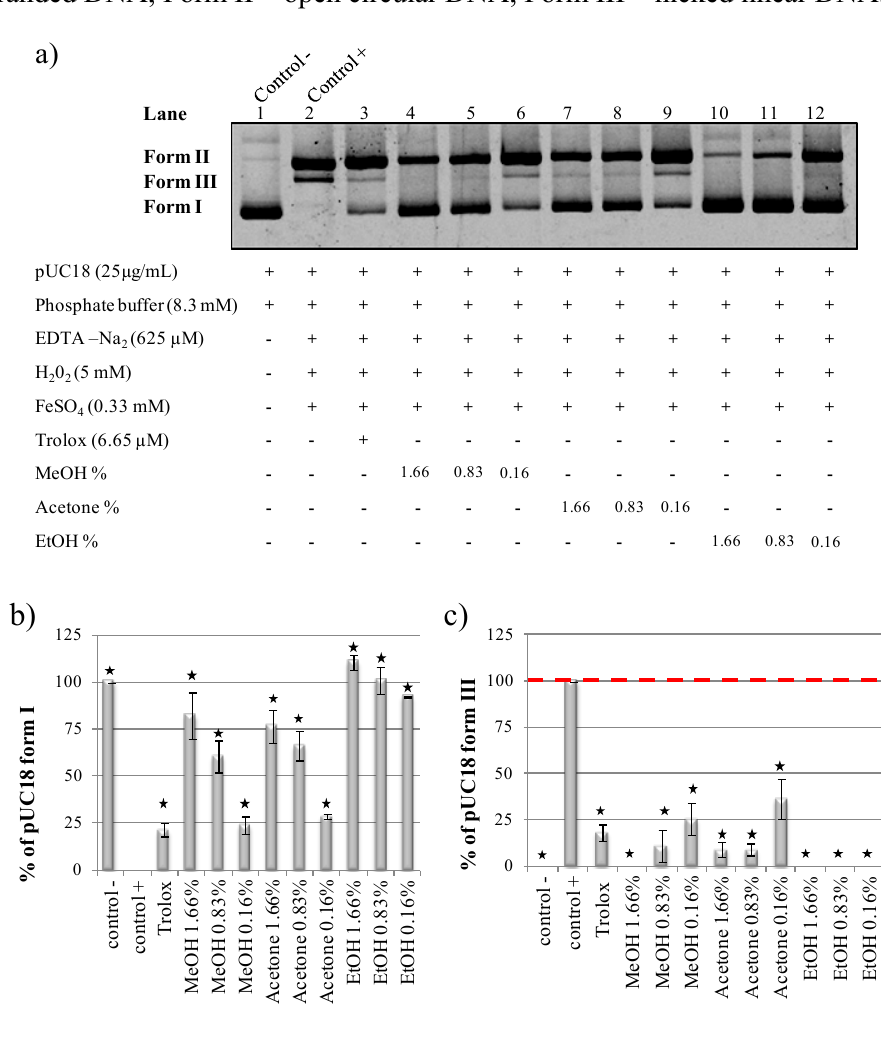
Figure 3. ( a ) Strand breaks protective capacity of methanol, acetone and ethanol; ( b ) Quantification of pUC18 form I protection; ( c ) Quantification of pUC18 form III formation. All the reaction mixtures were incubated for 20 min at 37 °C. Asterisks indicate significant differences between control+ and the other assays at p < 0.05. Form I—supercoiled double stranded DNA; Form II—open circular DNA; Form III—nicked linear